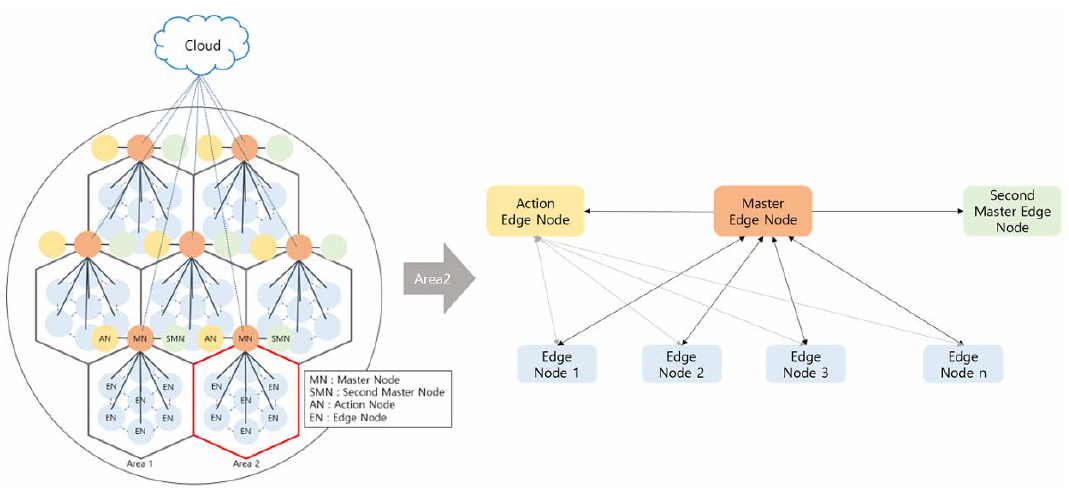
Figure 1. Architecture of the intelligent collaboration system.